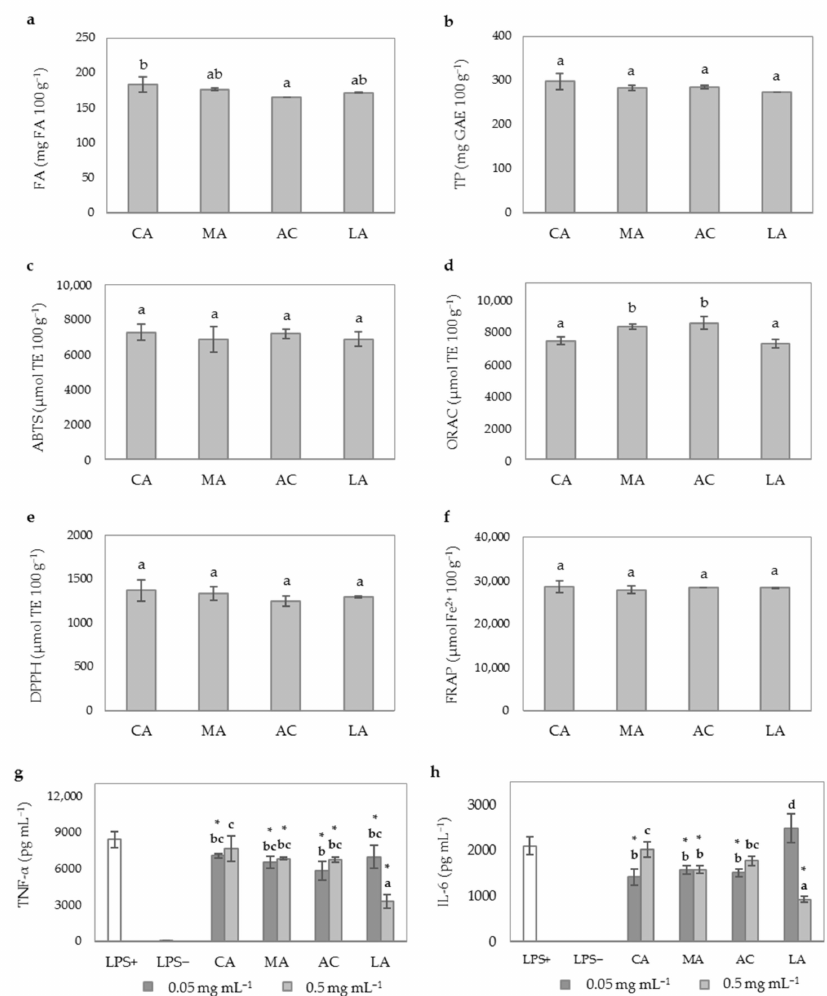
Figure 4. Effect of the type of organic acid used during WB hydrolysis by Ultraflo XL in optimal con- ditions (47 ◦ C, pH 5, 20 h) on phenolic compounds content, TAC and AIA of WB hydrolysates. ( a ) FA content (mg 100 g − 1 ); ( b ) TP content (mg GAE 100 g − 1 ); ( c ) ABTS scavenging activity ( µ mol TE 100 g − 1 ); ( d ) ORAC ( µ mol TE 100 g − 1 ); ( e ) DPPH scavenging activity ( µ mol TE 100 g − 1 ); ( f ) FRAP ( µ mol Fe 2+ 100 g − 1 ); ( g ) TNF- α concentration (pg mL − 1 ); ( h ) IL-6 concentration (pg mL − 1